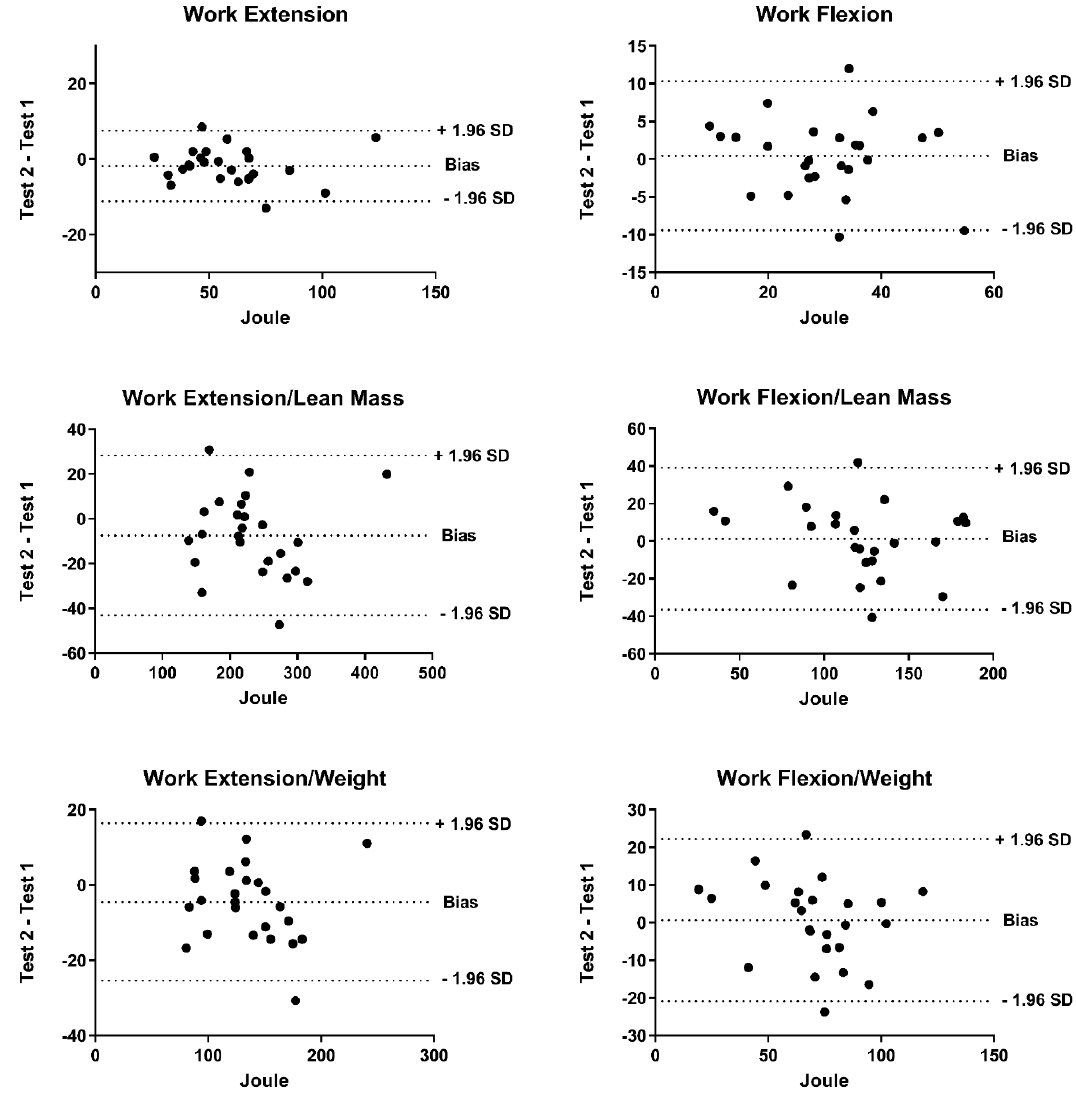
Figure 2. Bland–Altman plots work.